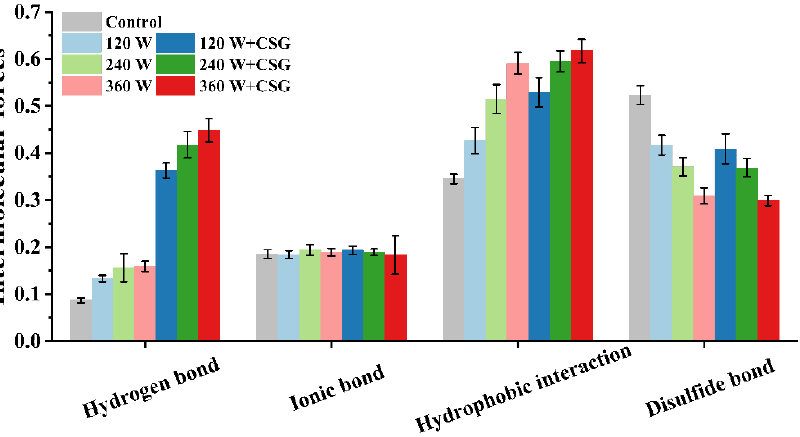
Figure 6. Intermolecular forces in WPI and WPI–CSG systems treated by different power ultra ‐ sound.